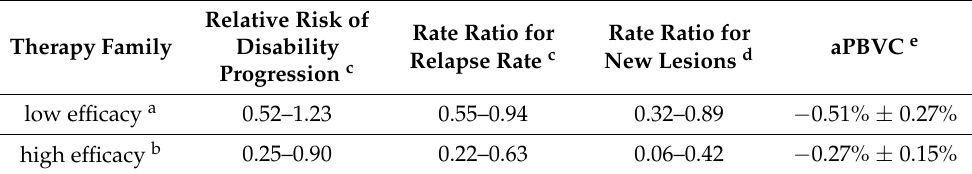
Table 2. Effectiveness of disease-modifying therapies on EDSS disability progression, relapses, new lesions, and brain volume loss. Relative Risk of Therapy Family